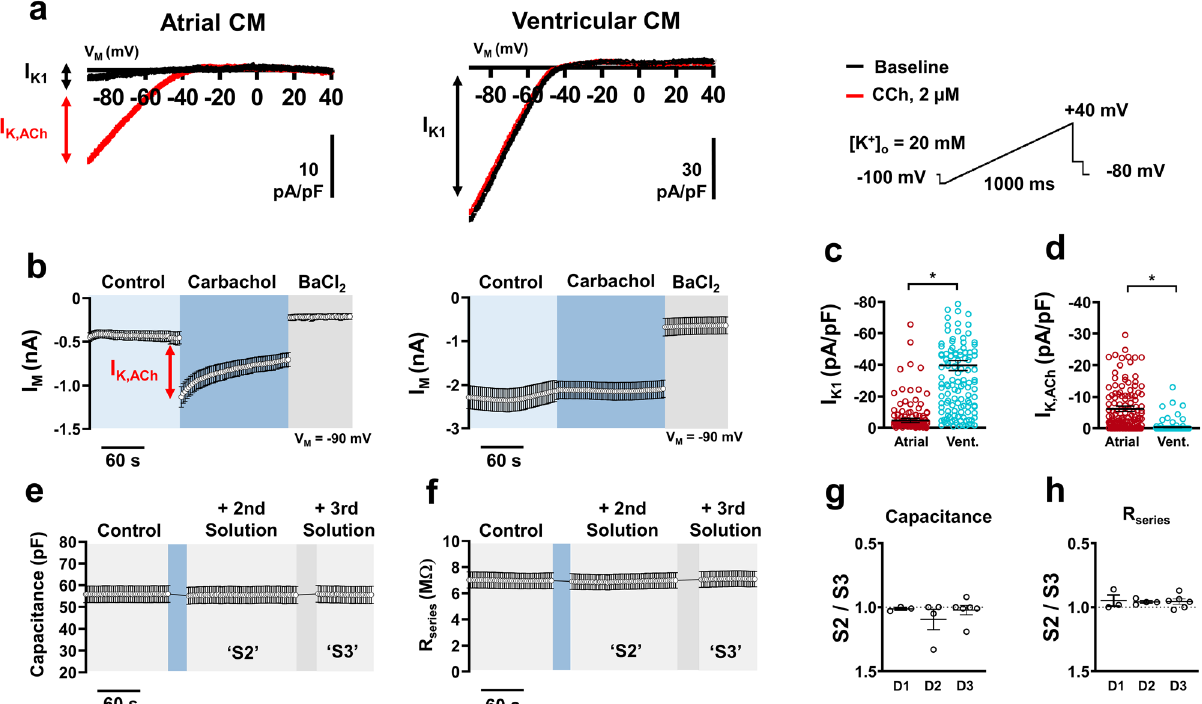
Fig. 5 Inward recti fi er acquisition from native atrial and ventricular cardiomyocytes (CM) using automated patch-clamp. a Representative traces of membrane current ( I M ) showing basal inward recti fi er current ( I K1 ) in atrial and ventricular (vent.) with superimposed acetylcholine-activated inward recti fi er ( I K,ACh ) current following carbachol (CCh) application during a depolarizing ramp voltage protocol. b Time course of a single plate with atrial ( n = 10) and ventricular ( n = 11) CMs inward current at − 90 mV during a typical experiment. Red arrow indicates peak I K,ACh . c Peak inward I K1 density measured at − 90 mV. d Peak inward I K,ACh density measured at − 90 mV. e Time course of membrane capacitance from a single plate ( b , [ n = 10]) over various external solution changes. f Time course of series resistance ( R series ) from a single plate ( b , [ n = 10]) over various external solution changes. g Ratio of mean capacitance changes per plate between solution change 2 (S2) and solution change 3 (S3) over three separate experimental days (D1, D2, D3). h Ratio of R series between S2 and S3 over three separate experimental days. Data are mean ± SEM. *P < 0.05 vs. ventricular. n = number of atrial (151) and ventricular (143) CMs from three animals ( c , d